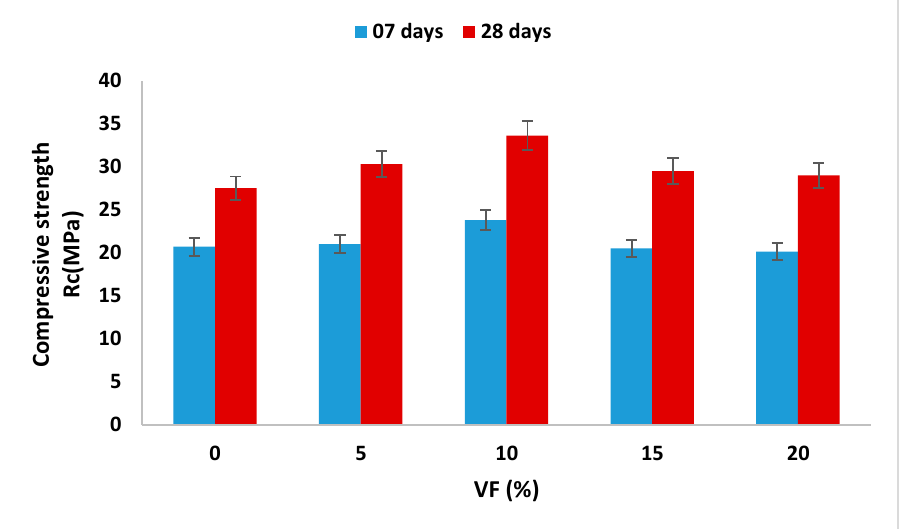
Figure 8. Effect of PO fibers on the compressive strength of the mixtures.